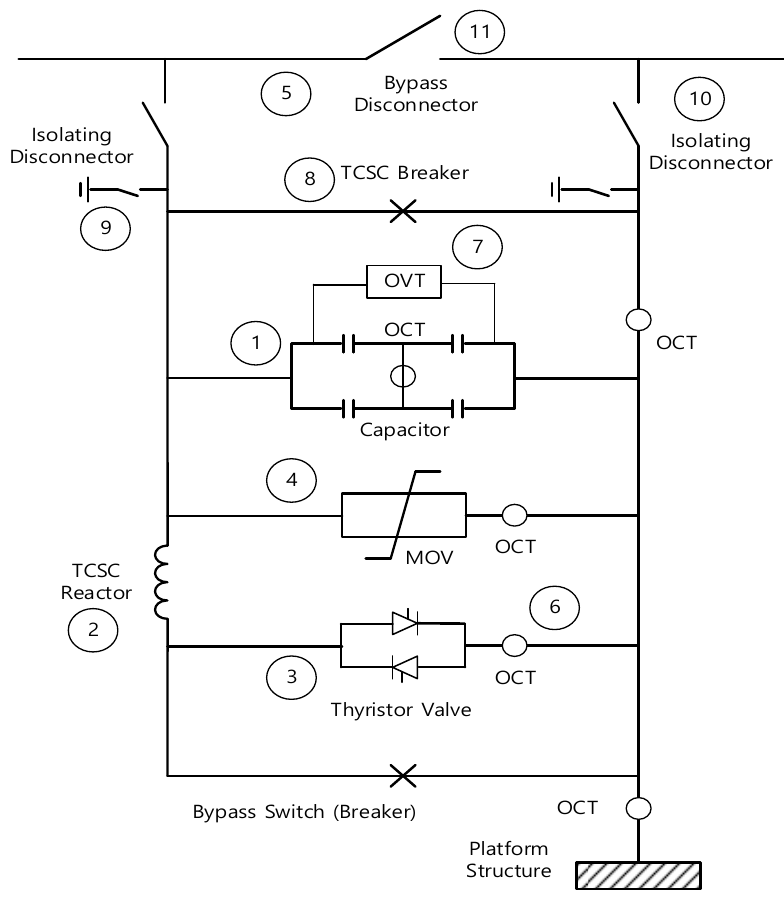
Figure 3. TCSC main components.